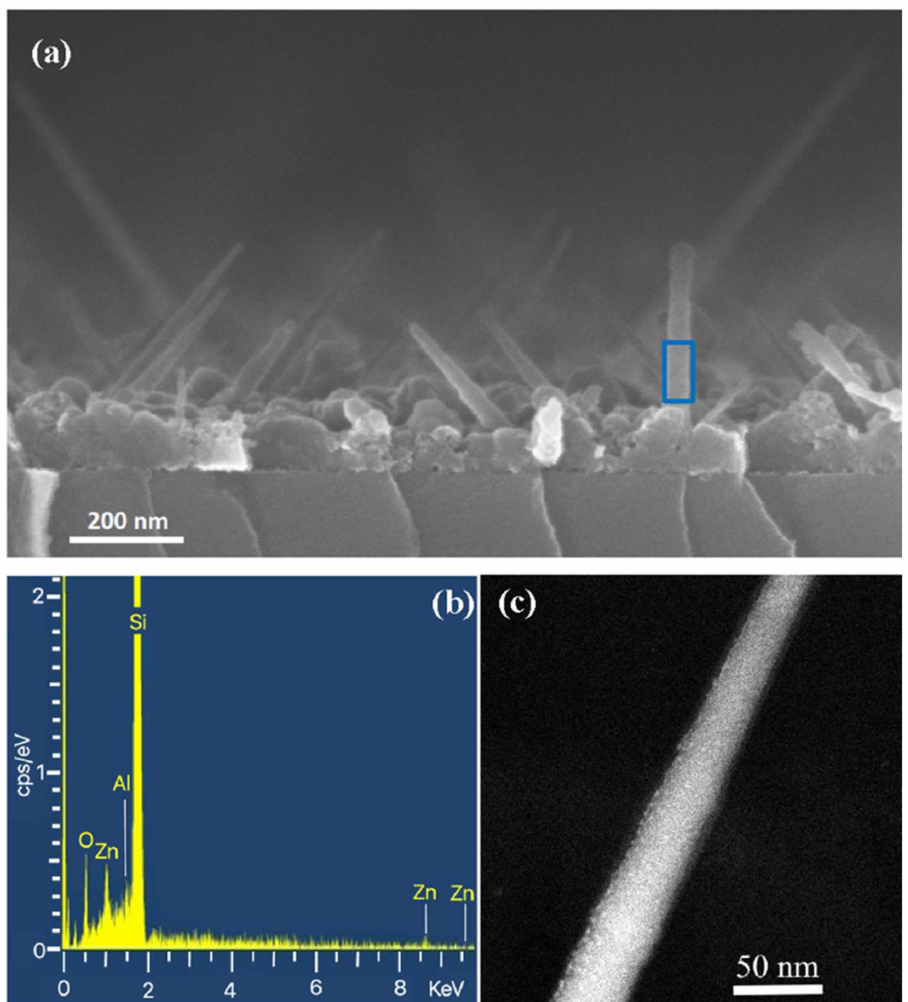
Figure 4. ( a ) Cross-SEM analysis of 20 nm thick AZO layer deposited on Si-NW. ( b ) EDX spectrum extracted from the NWs area referred to in letter a. ( c ) STEM micrograph of a single Si-NW coated with the equivalent 20 nm thickness of